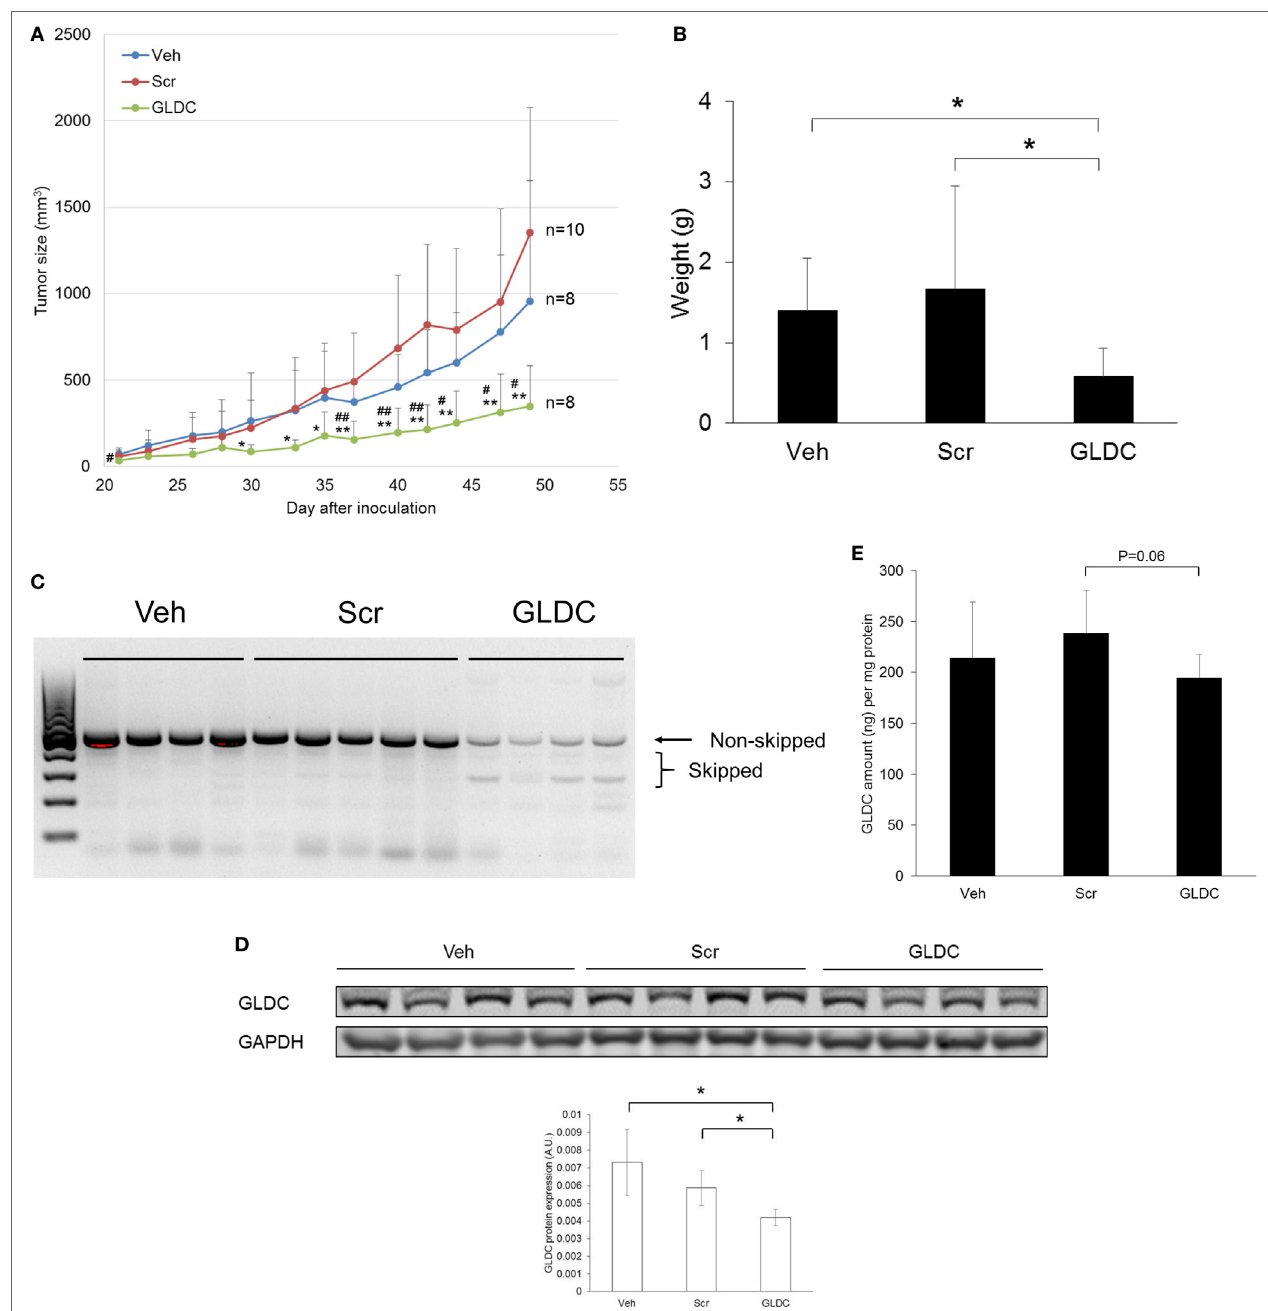
FigUre 3 | Glycine decarboxylase (GLDC) inhibition suppresses lung tumor xenograft. (a) Tumor growth progression of all treatment groups. TS32 cells were subcutaneously injected into the right flank of NOD-SCID mice followed by 7 weeks of treatment. Data represent mean tumor volume ± SD. GLDC versus Veh: # p < 0.05 and ## p < 0.01. GLDC versus Scr: * p < 0.05 and ** p < 0.01. (B) Tumor weight of all treatment groups. Tumor tissues were harvested at the end of the study for weight measurement. Data represent mean tumor weight ± SD (* p < 0.05). (c) Representative image of agarose gel electrophoresis of polymerase chain reaction (PCR) products for tumor tissues in all treatment groups. After tissue homogenization, total RNA was harvested for cDNA synthesis followed by PCR amplification for exon skipping detection. (D) The protein expression of GLDC in tumor tissues from each treatment group. The data are the best representative of three independent experiments (* p < 0.05). (e) GLDC ELISA assay for tumor tissues in all treatment groups. After homogenization, tissue lysates were used for the